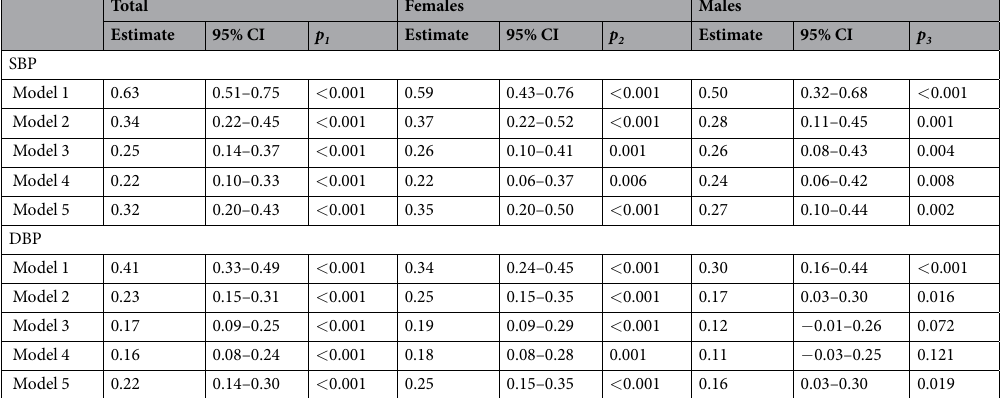
Table 2. Estimated absolute increases in blood pressure (mmHg) with 95% CI per unit of neck circumference. SBP, systolic blood pressure; DBP, diastolic blood pressure; CI, confidence interval. Model 1, unadjusted; Model 2, adjusted for age, fasting blood glucose, smoking and drinking status, salt consumption, physical activity, family history of hypertension, and history of hypertension; Model 3, adjusted for model 2 + body mass index categories; Model 4, adjusted for model 2 + waist circumference categories; Model 5, adjusted for model 2 + waist-to-hip ratio.